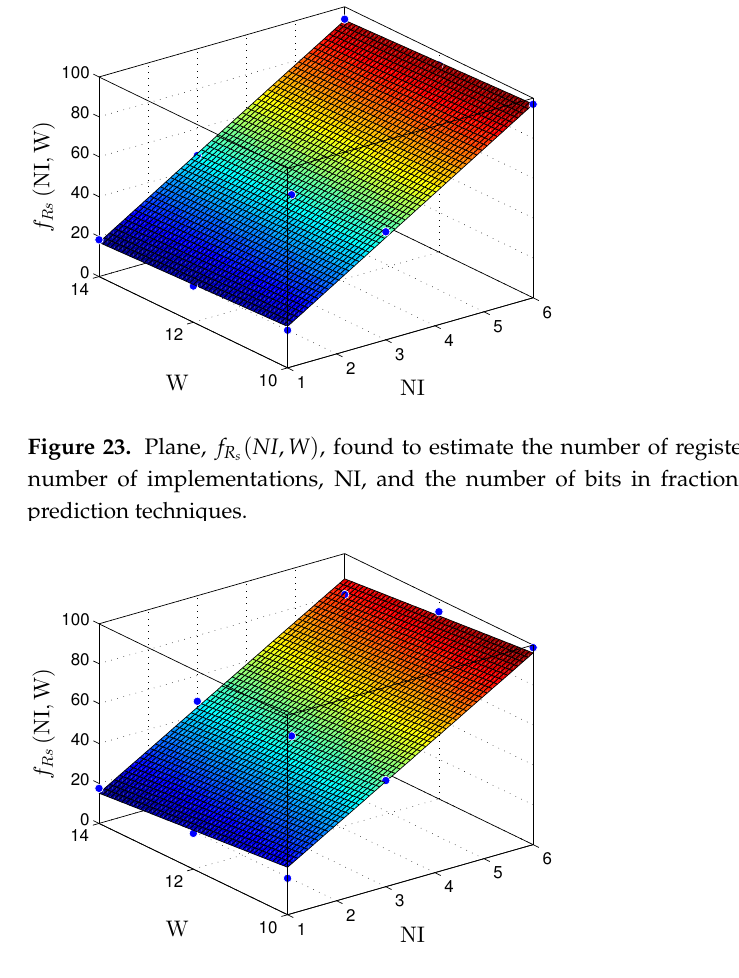
( NI , W ) , found to estimate the number of registers, R s , as a function of the Figure 24. Plane, f R s number of implementations, NI, and the number of bits in fractional part W, for RMLP-based prediction